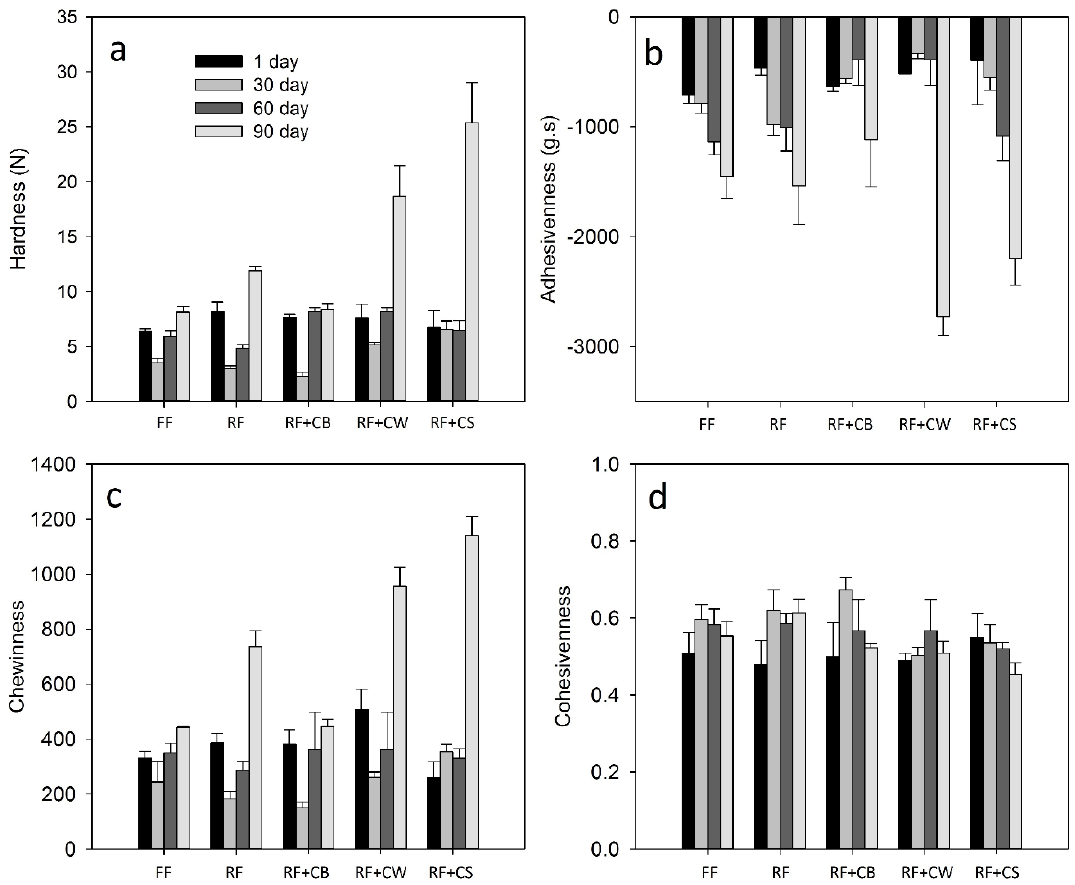
Figure 6. Texture parameters of the tested cheeses over ripening. ( a ) Hardness; ( b ) Adhesivenness; ( c ) Chewinness; ( d ) Cohesivenness. (FF): full-fat; (RF): reduced-fat; (RF + CB): reduced-fat with concentrated buttermilk; (RF + CW): reduced-fat with concentrated whey; (RF + CS): reduced-fat with concentrated second cheese whey.